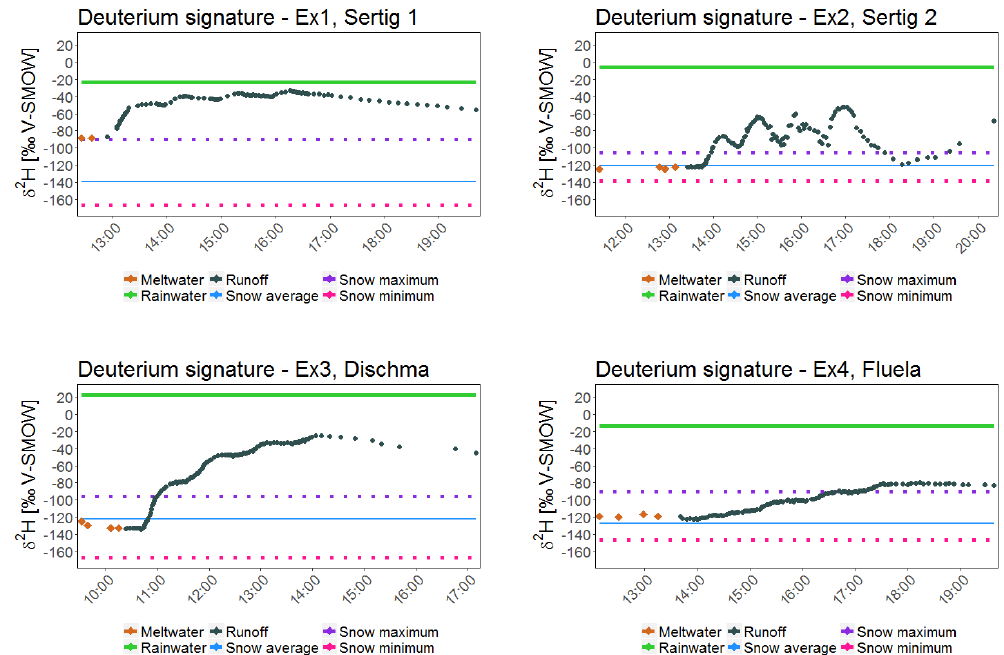
Figure 4. Deuterium signature of the snowpack runoff during sprinkling (blue dots) or pre-sprinkling meltwater (red dots). The lines represent the range (minimum and maximum) and averages of the deuterium signature derived for snow samples and the sprinkling water